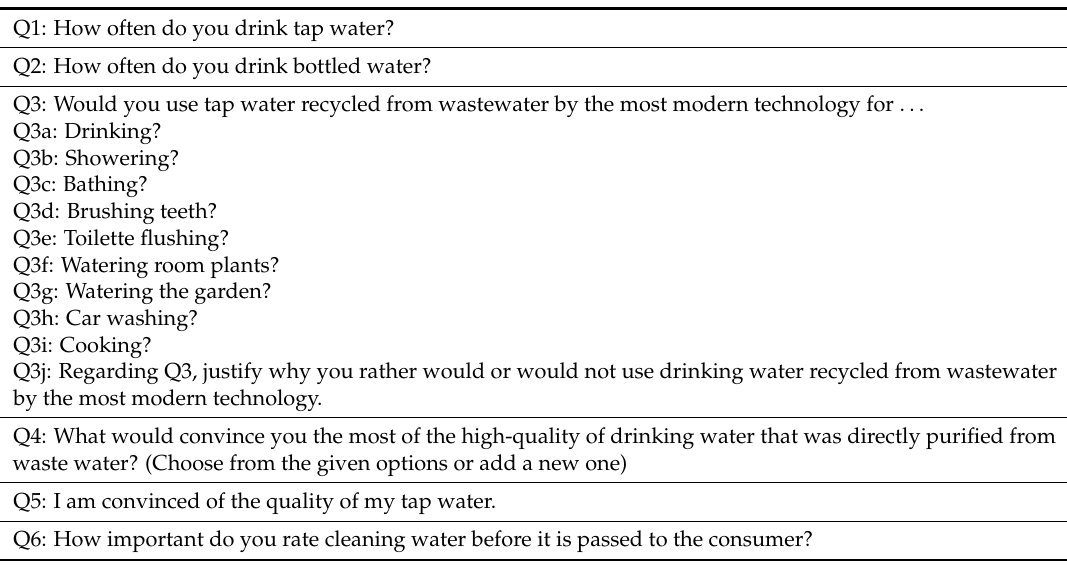
Table 1. Questionnaire questions. Except for Q3j and Q4, all questions were closed questions with a Likert scale of 1 (refusal/never) to 4